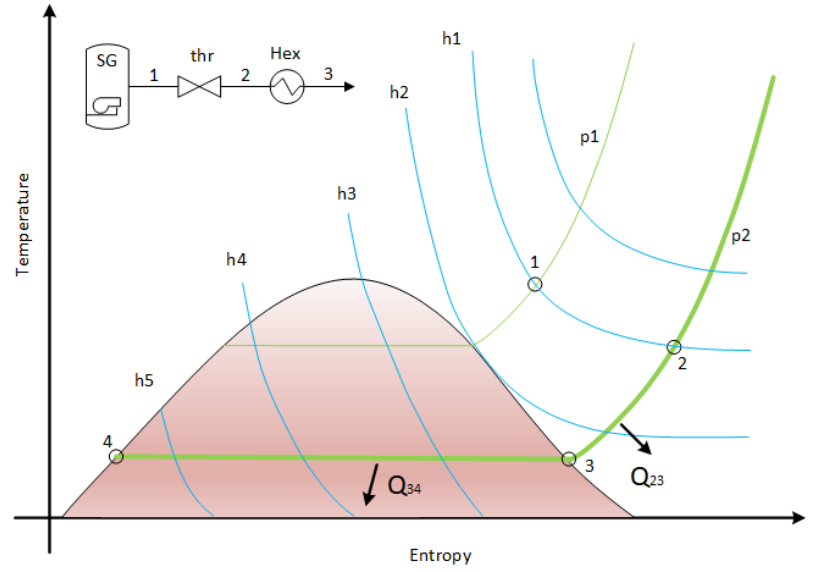
Figure 1. Steam conditioning with throttle and heat exchanger shown in a TS diagram, SG: Steam Generator, thr: Throttle, Hex: Heat